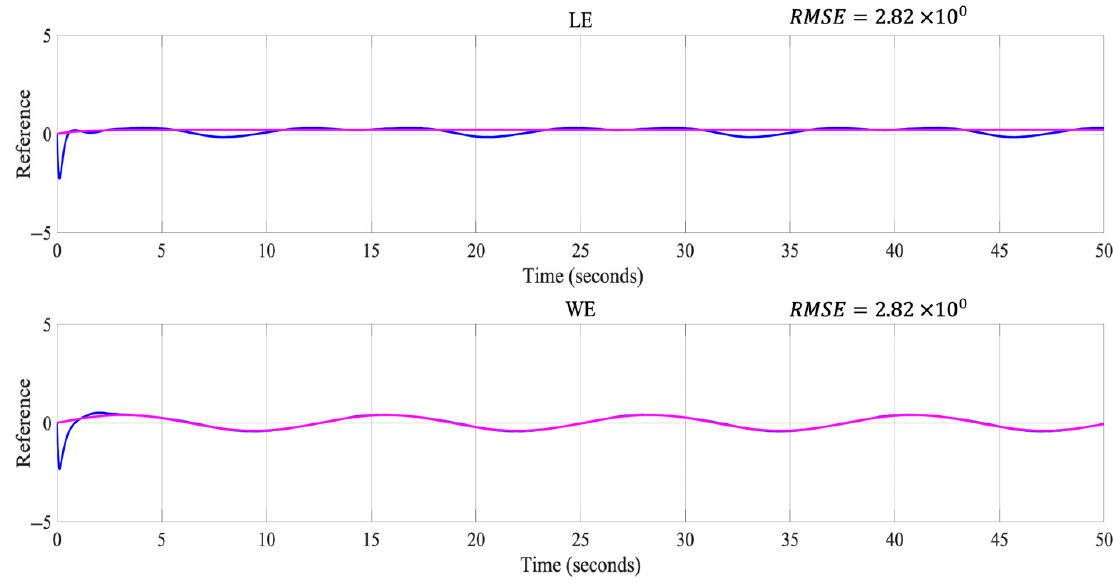
Figure 9. Representation of the best result representing the LE and the WE without disturbance